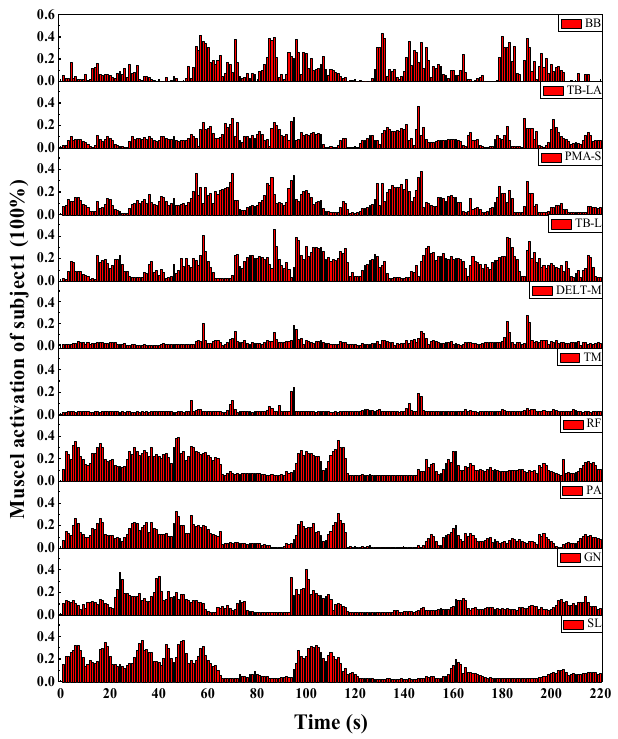
Figure 8. Muscle activation analysis.